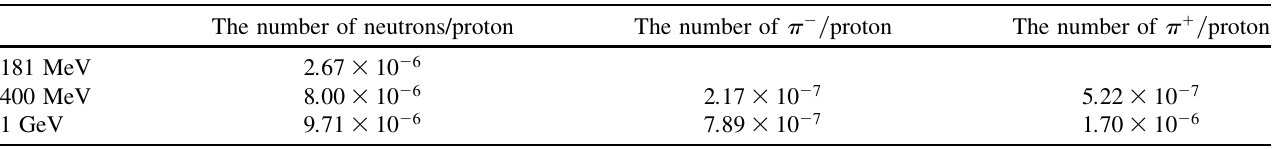
TABLE I. Production number of secondary particles.